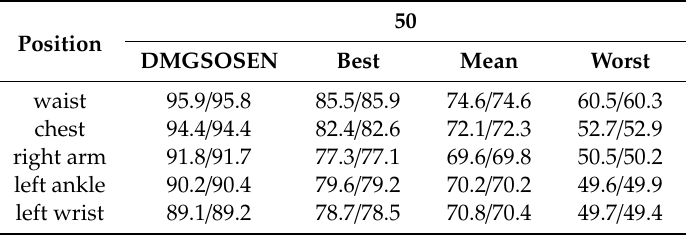
Table 2. Performance of the ensembles for initial pool sizes of 50 (Accuracy / F1%).